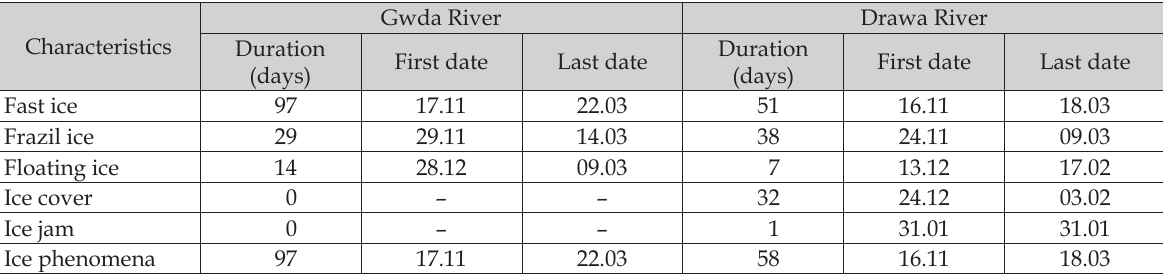
Table 3. Ice phenomena in the Gwda River in Piła and the Drawa River in Drawiny in 1961–2010